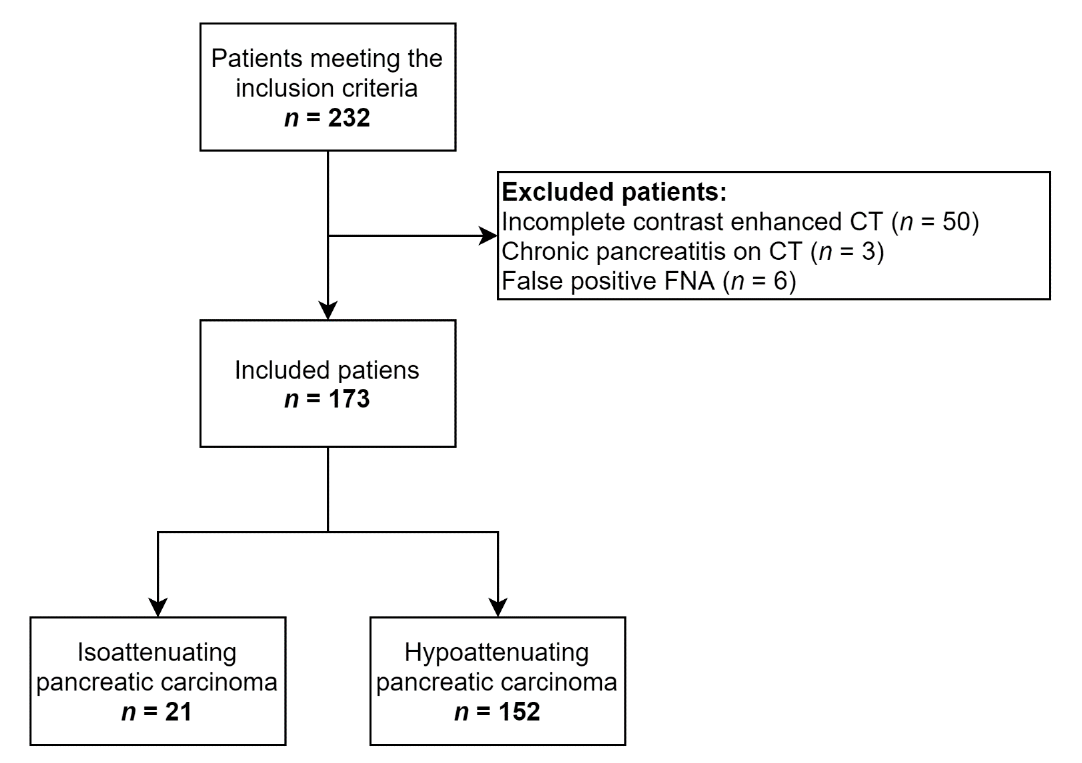
Figure 1. Flowchart demonstrating included patients. Table 1. List of inclusion and exclusion criteria of the study. Inclusion criteria Definite diagnosis of pancreatic